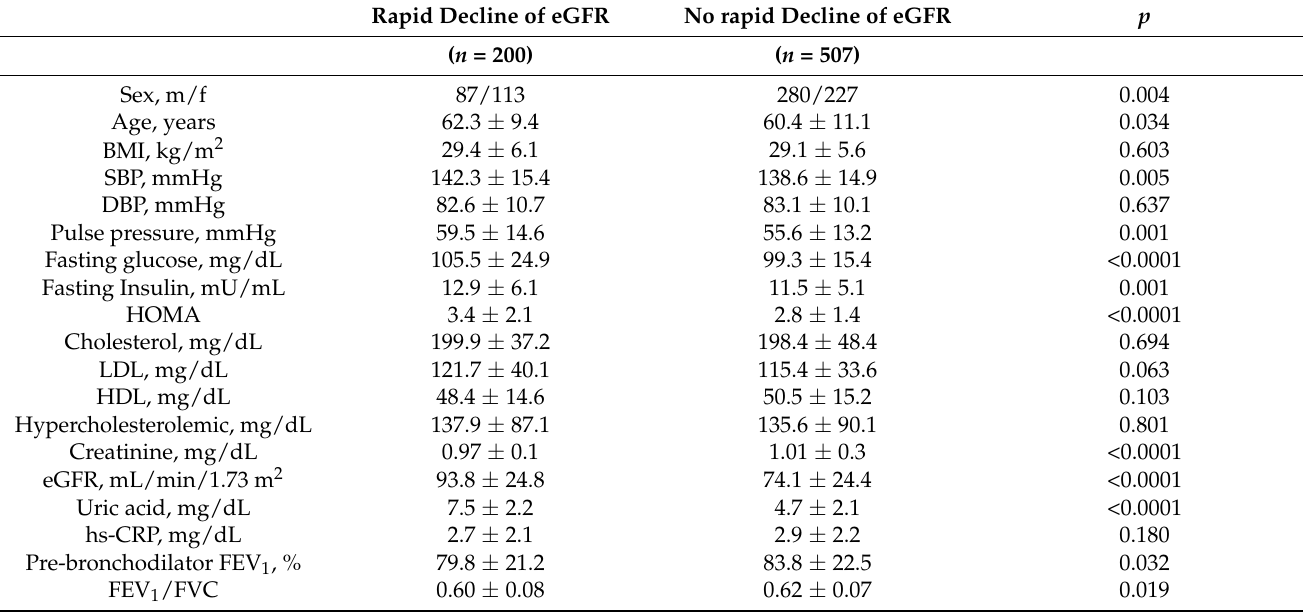
Table 4. Anthropometric, hemodynamic, and biohumoral characteristics, stratified according to the presence or absence of rapid decline of renal function (>5 mL/min/1.73 m 2